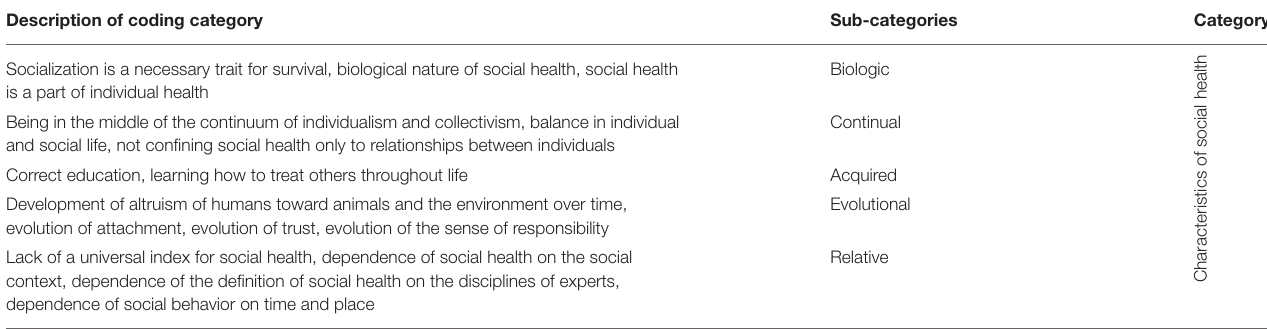
TABLE 4 | Categories, sub-categories and codes obtained from interviews with participants. Description of coding